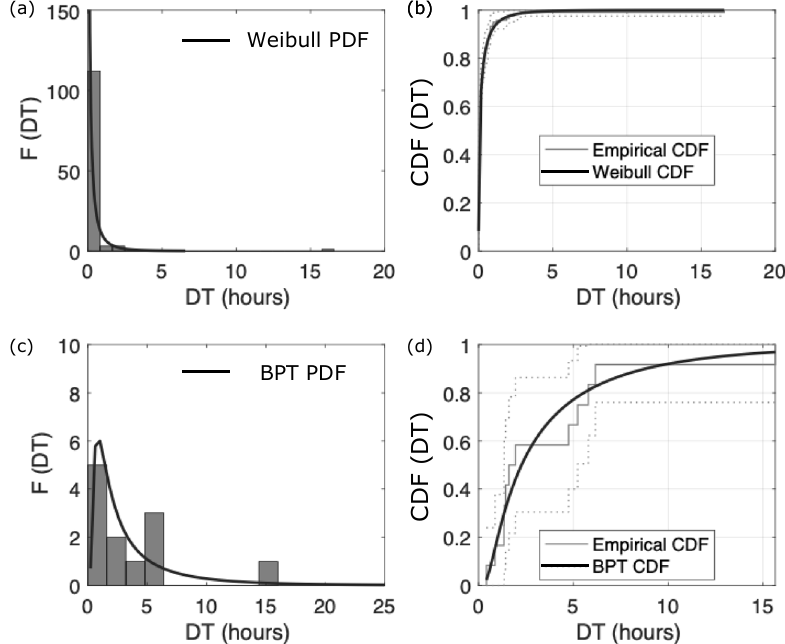
Figure 4. Inter-arrival times distribution. The left column reports the distribution (in terms of frequency F) of the inter-arrival times DT. Panels ( a ) and ( c ) correspond to the phase 2 and phase 4, respectively. The black line depicts the best fit distribution, which corresponds to the Weibull PDF in panel ( a ) and to the Brownian Passage time PDF in panel ( b ). Panels ( c ) and ( d ) show the cumulative distribution used for the Kolmogorov-Smirnov test. The dashed lines represent the confidence bound.